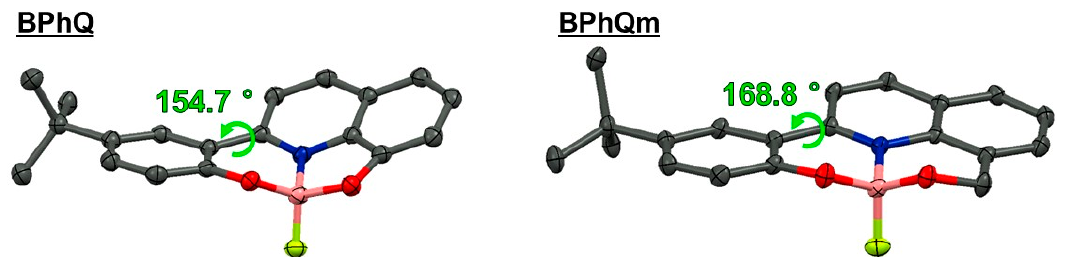
Figure 1. Thermal ellipsoid (probability level 50%) of BPhQ ( left ) and BPhQm ( right ) ( gray , carbon atoms; blue , nitrogen atoms; red , oxygen atoms; pink , boron atoms; yellow , fluorine atoms. Hydrogen atoms are omitted for clarity).